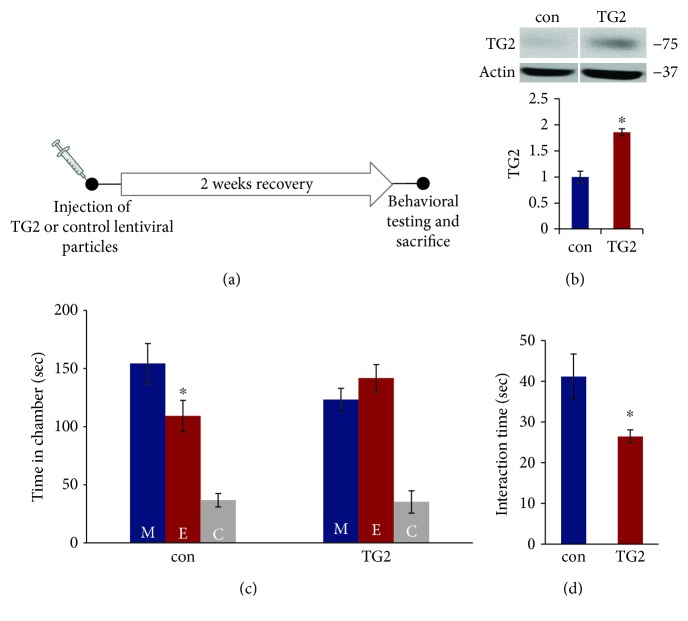
TG2 overexpression in the PFC induces social interaction deficits in mice. (a) Schematic representation of stereotaxic injection of control or TG2 lentiviral particles into the mouse PFC. (b) Increase in TG2 expression in the PFC of mice injected with TG2 lentiviral particles. Top: representative blot. Bottom: quantification of TG2 normalized to actin. Protein levels were measured by western blot analysis. ∗p < 0.05; Student's t-test. N = 3 (control) and 4 (TG2). (c–d) TG2 overexpression induced deficits in social behavior. (c) The three-chamber social interaction test. ∗p < 0.05 (E vs. M); two-way ANOVA. (d) Reciprocal social interaction test. ∗p < 0.05 vs. con group; one-way ANOVA. N = 7 mice per group. Data are expressed as mean ± SEM. M: chamber housing stranger mouse; E: chamber housing an empty cage; C: center.